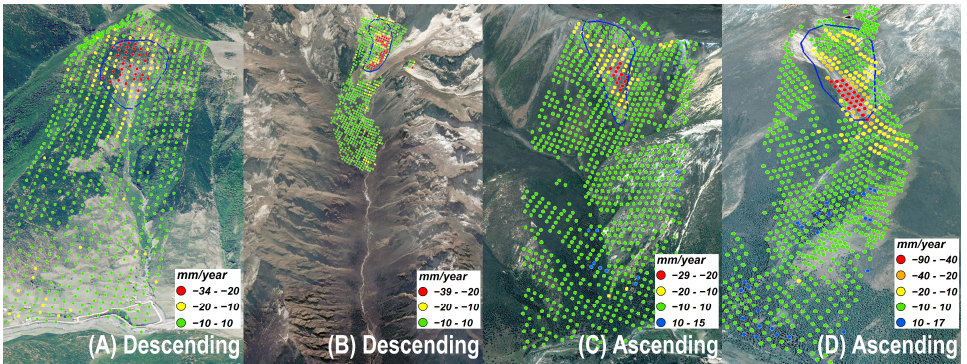
Figure 7. LOS velocity of typical debris flows. The base map is the Tianditu images with a spatial resolution of 1 meter. The blue line represents the boundary of debris flows.